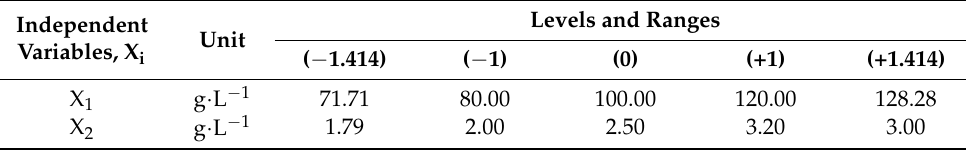
Table 6. Experimental range and levels of